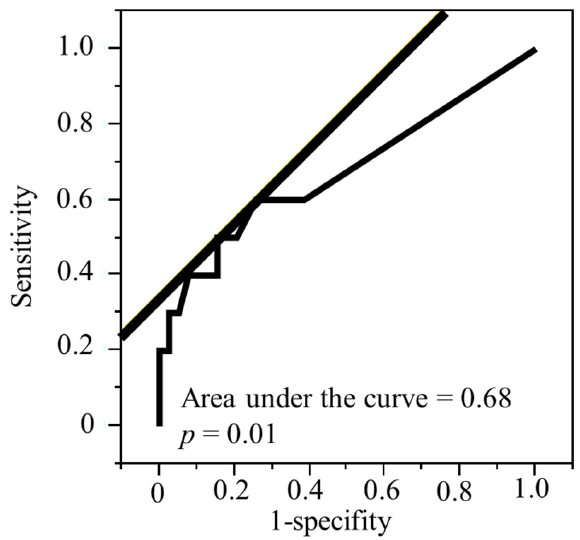
Figure 2. Receiver operating curves for 49 patients with head and neck squamous cell carcinoma.